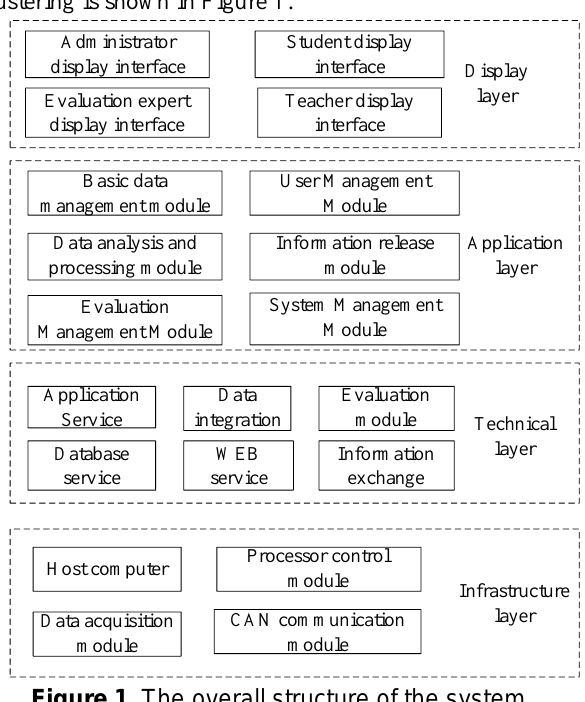
Figure 1. The overall structure of the